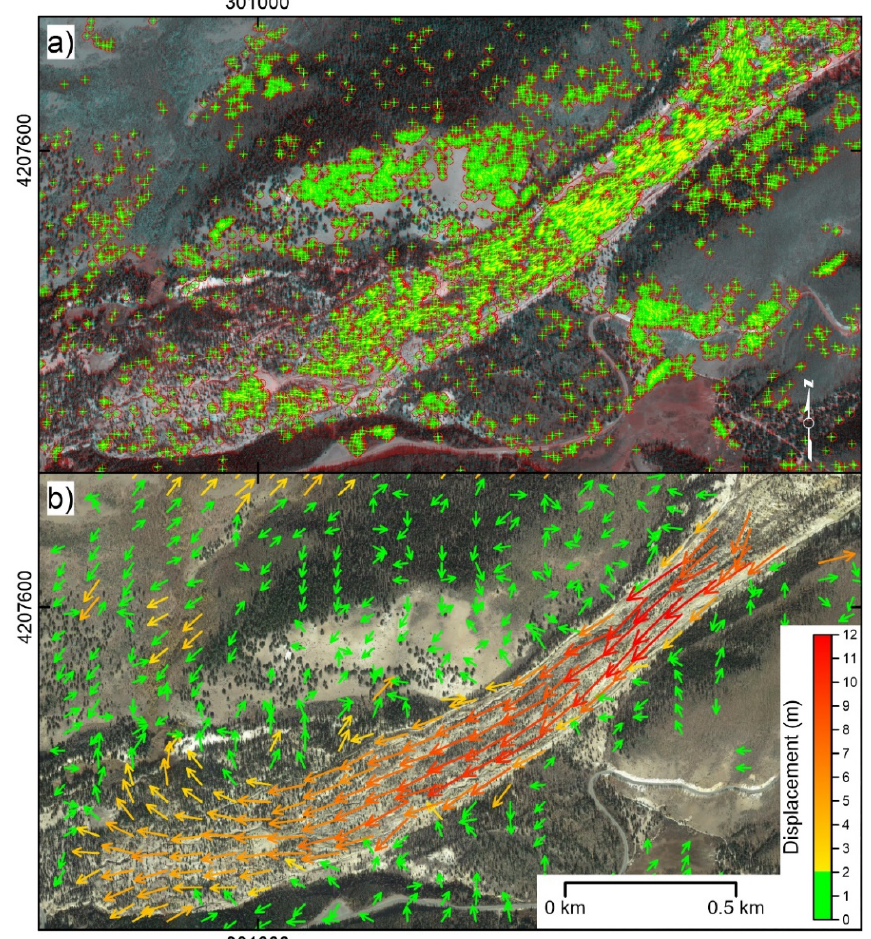
Figure 4. Slumgullion landslide and surrounding slopes. ( a ) Eigen features identified and tracked within the study area. Centroid of red symbols indicates feature position in the master image (i.e., 6 June 2013), while green crosses indicate feature position in the slave image (i.e., 14 October 2015). ( b ) Displacement field map derived by eigen-feature tracking after deviation correction. UTM coordinates are shown at figure edges. Map data 2020 © Maxar Technologies.